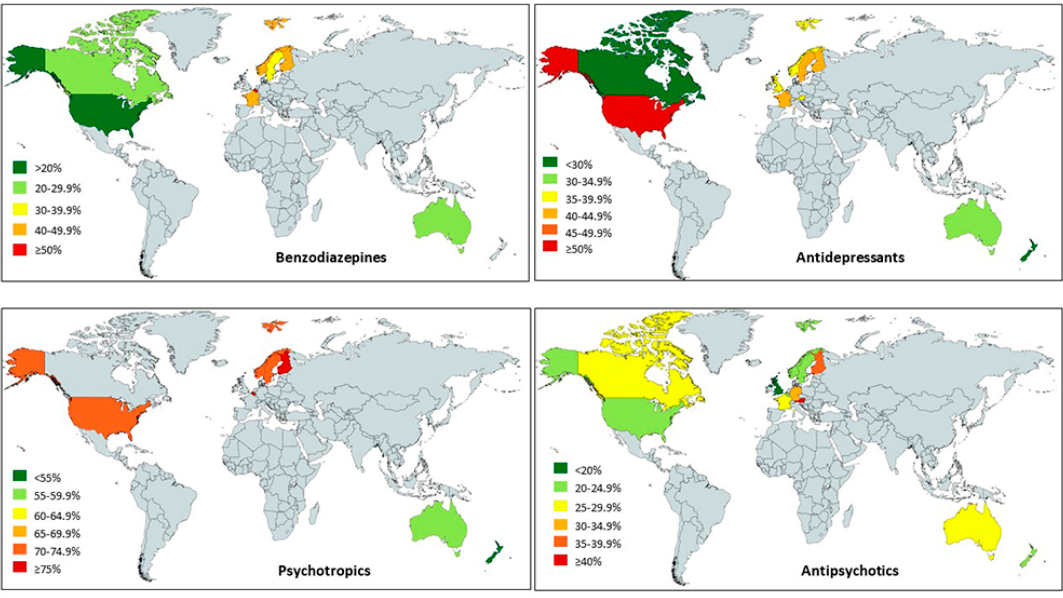
Figure 3. Use of psychotropic, antipsychotic, antidepressant and benzodiazepine drugs among care home residents (countries with at least 2 studies were included). Table 5. Use of di ff erent CNS drugs by residents of care homes by country. Table 4. Use of different CNS drugs by residents of care homes by countries. Country No. Country